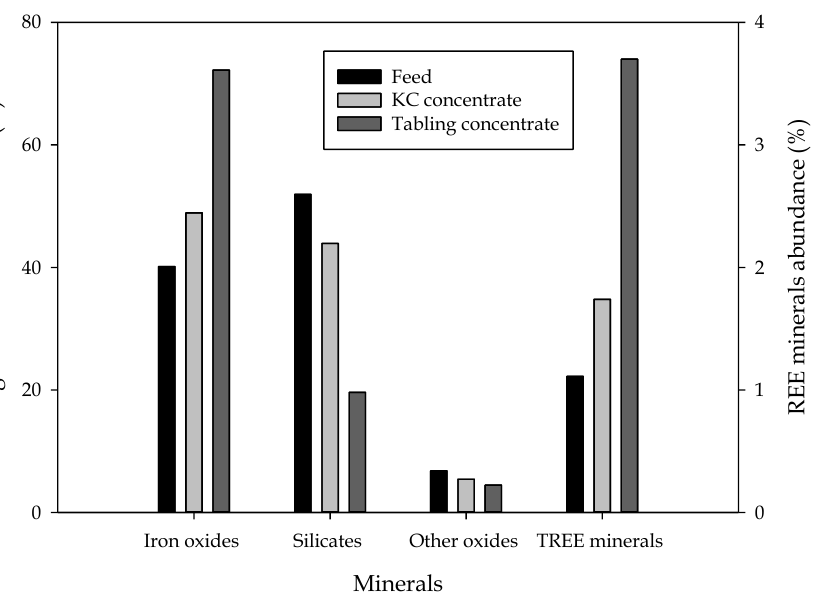
Figure 4. Mineral mass abundance of TREE and gangue minerals in the feed and gravity (KC and tabling) concentrates.